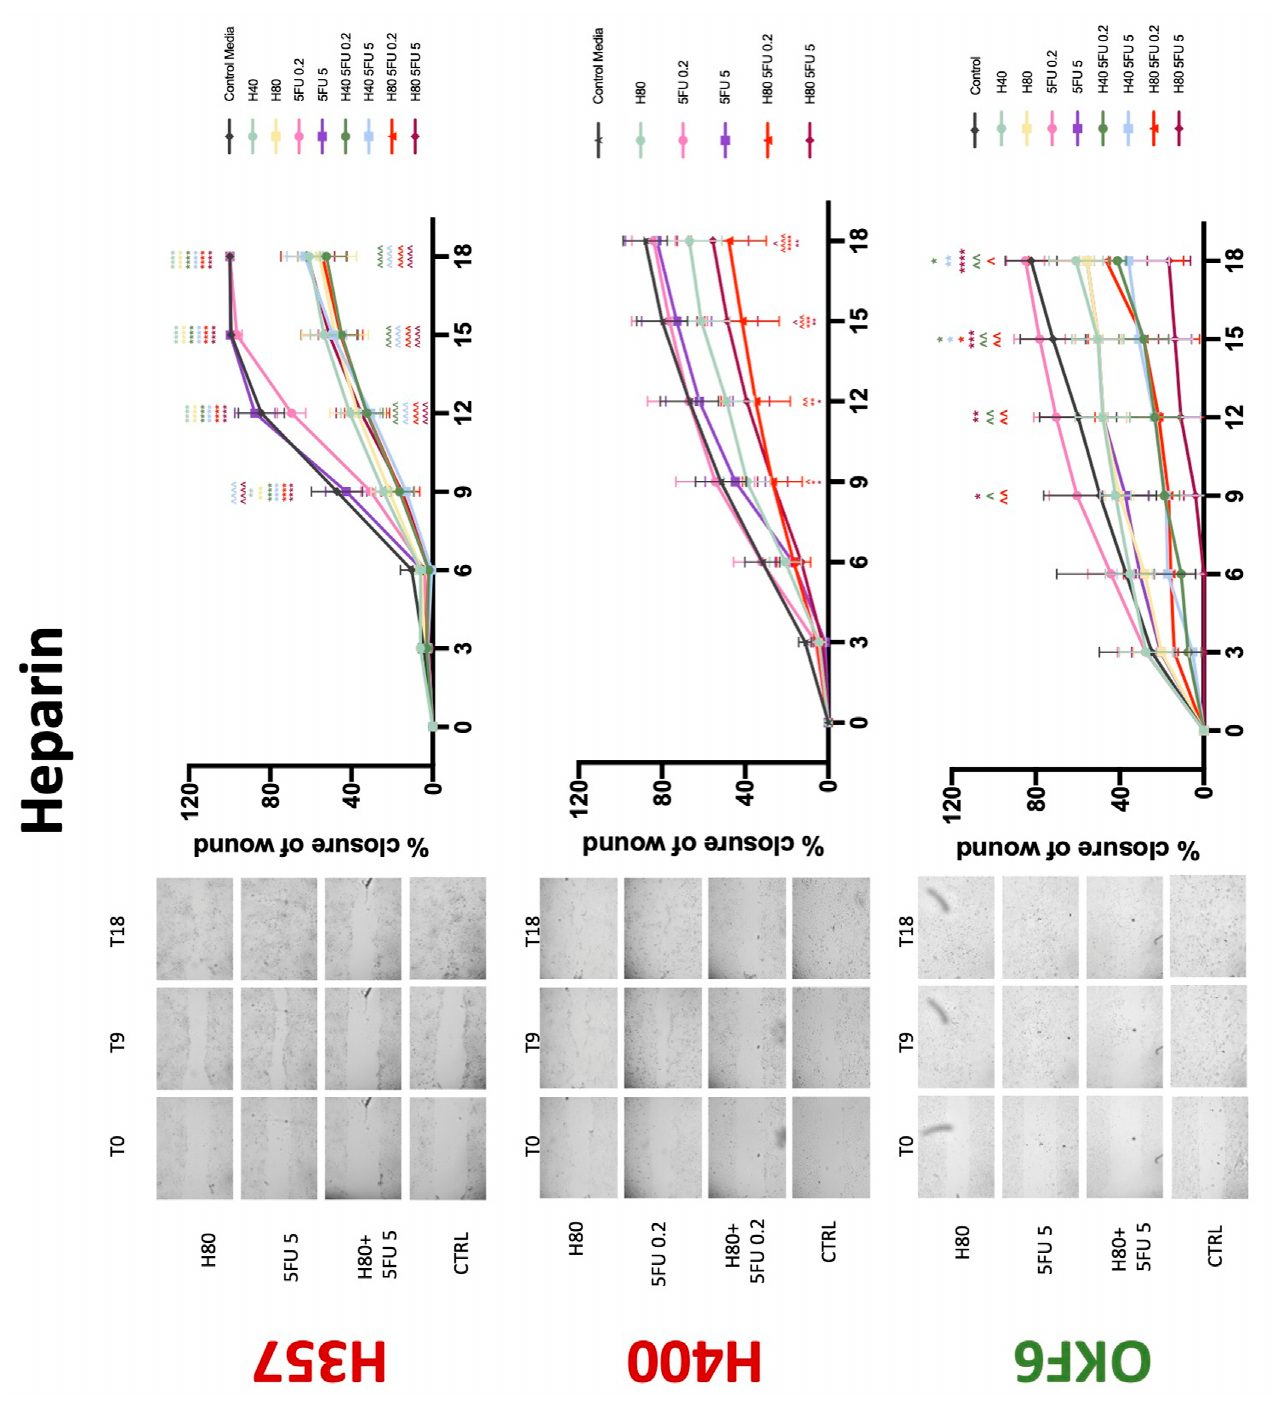
Figure 8. Wound healing assay . The effect of (40/80 U) heparin and (0.2/5 μ g/mL) 5-FU on H357, H400, and OKF6 cell migration. Data are represented as mean ± SD. Statistical significance is given as follows: * p < 0.05, ** p < 0.01, *** p < 0.005, **** p < 0.001; (*) compared to control group; ^^ p < 0.01, ^^^ p < 0.005 , ^^^^ p < 0.001; (^) compared to respective 5-FU groups.